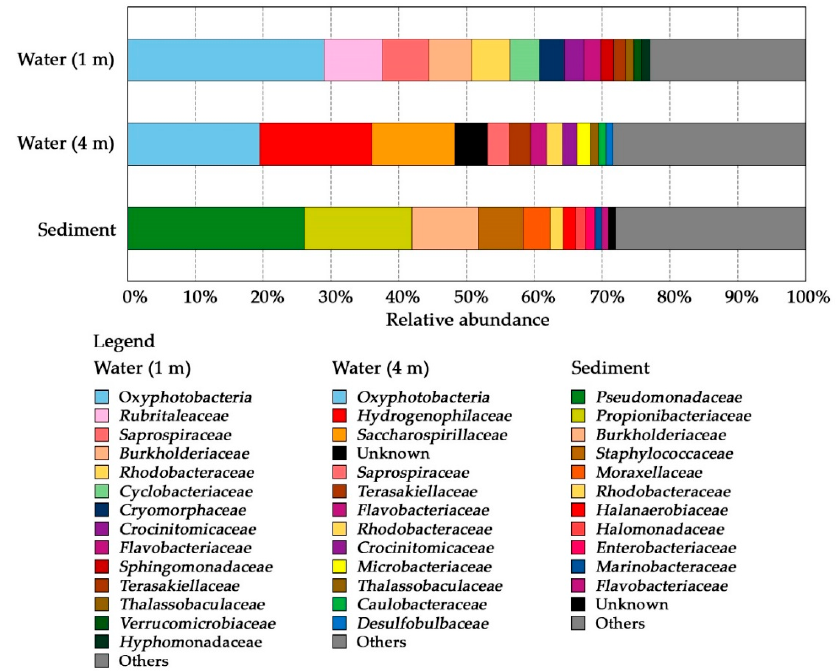
Figure 3. Relative abundance (%) of major families identified in water (1 m and 4 m) and sediment samples from Lake Alboraj. Only families with a relative abundance >1% of total bacterial population were included.